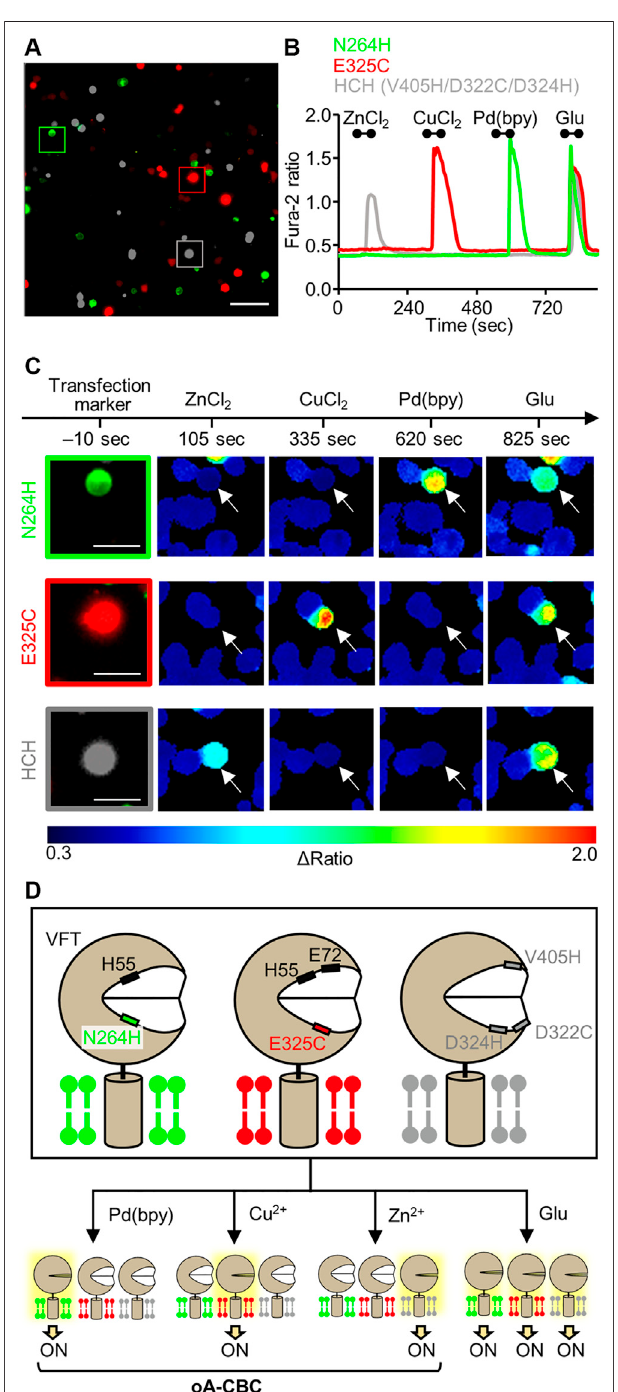
FIGURE 4 | Orthogonal activation of three mGlu1 mutants with Pd(bpy), Cu 2+ , and Zn 2+ . (A) Merged fl uorescent images of HEK293 cells transfected with N264H (green), E325C (red), or HCH mutant (gray). The scale bar shows 100 μ m. (B) Orthogonal activation of the N264H, E325C, HCH mutant